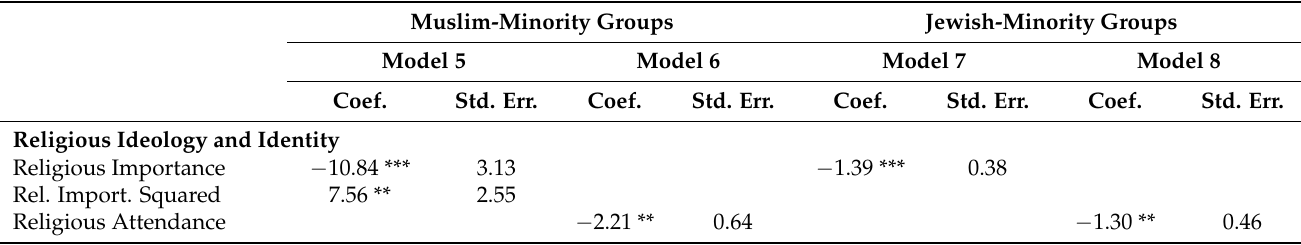
Table 3. Negative binomial regression predicting the relationship between societal discrimination of religious minority groups and country characteristics—by religious minority group in Christian-majority